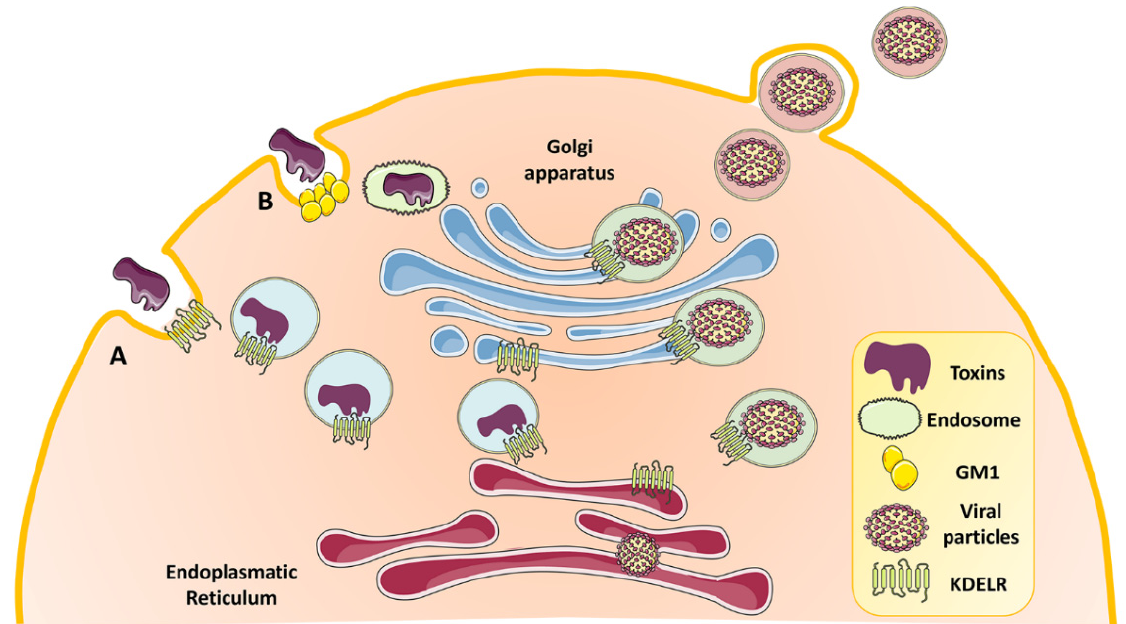
Figure 4. KDELR is involved in the internalization, trafficking, and secretion of toxins and viral particles. ( A ) Surface-expressed KDELRs can carry the internalization of toxins. ( B ) Cholera toxin (CTX) can be internalized by endocytosis after binding to GM1 ganglioside. After uptake, the A subunit of CTX dissociates and is transported to the Golgi and ER. Retrograde transport of the toxin from the Golgi to the ER is mediated by KDELRs through COPI vesicles. Furthermore, KDELRs are involved in the intracellular trafficking and maturation of viral particles.